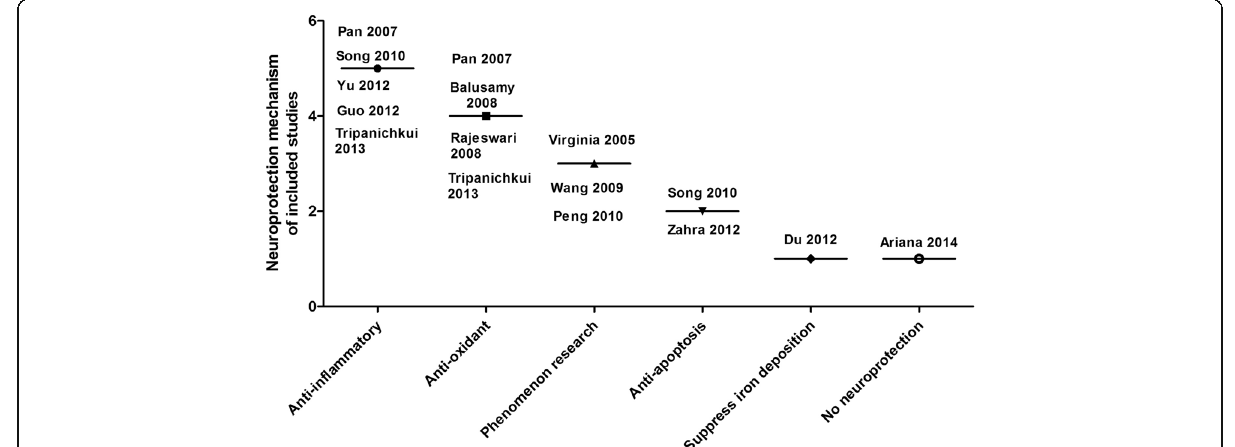
Fig. 2 Neuroprotection mechanisms for curcumin in treating Parkinson ’ s